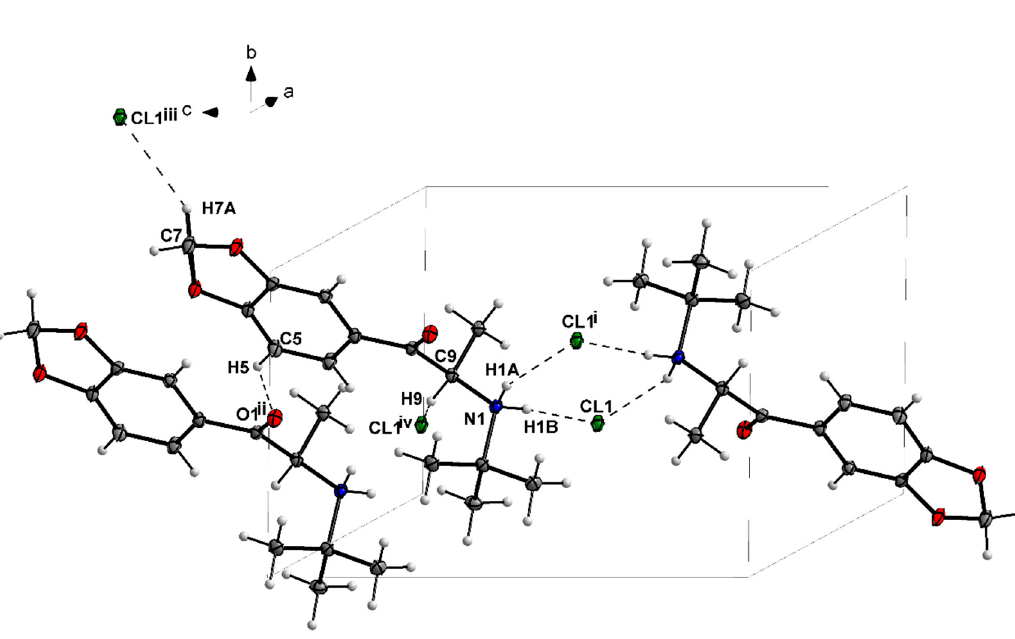
Figure 6. Part of the crystal structure of Compound 2 , showing H-bonding between neighboring ions (dashed lines). Symmetry codes: (i) − x + 1, − y + 1, − z + 1; (ii) x − 1, y , z ; (iii) x , y + 1, z + 1; (iv) − x , − y +